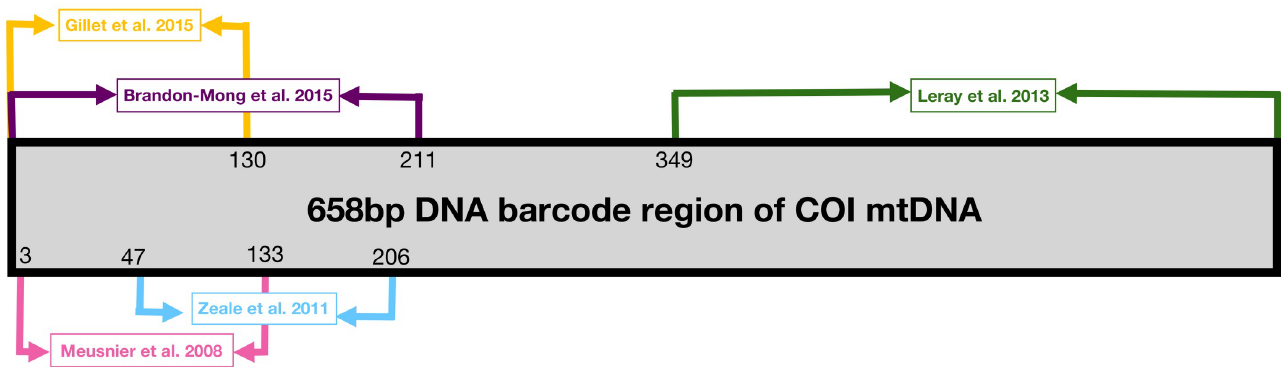
Fig 2. Primer locations. Visual representation of the marker locations in the mitochondrial COI (modified from Brandon-Mong et al. [22]).